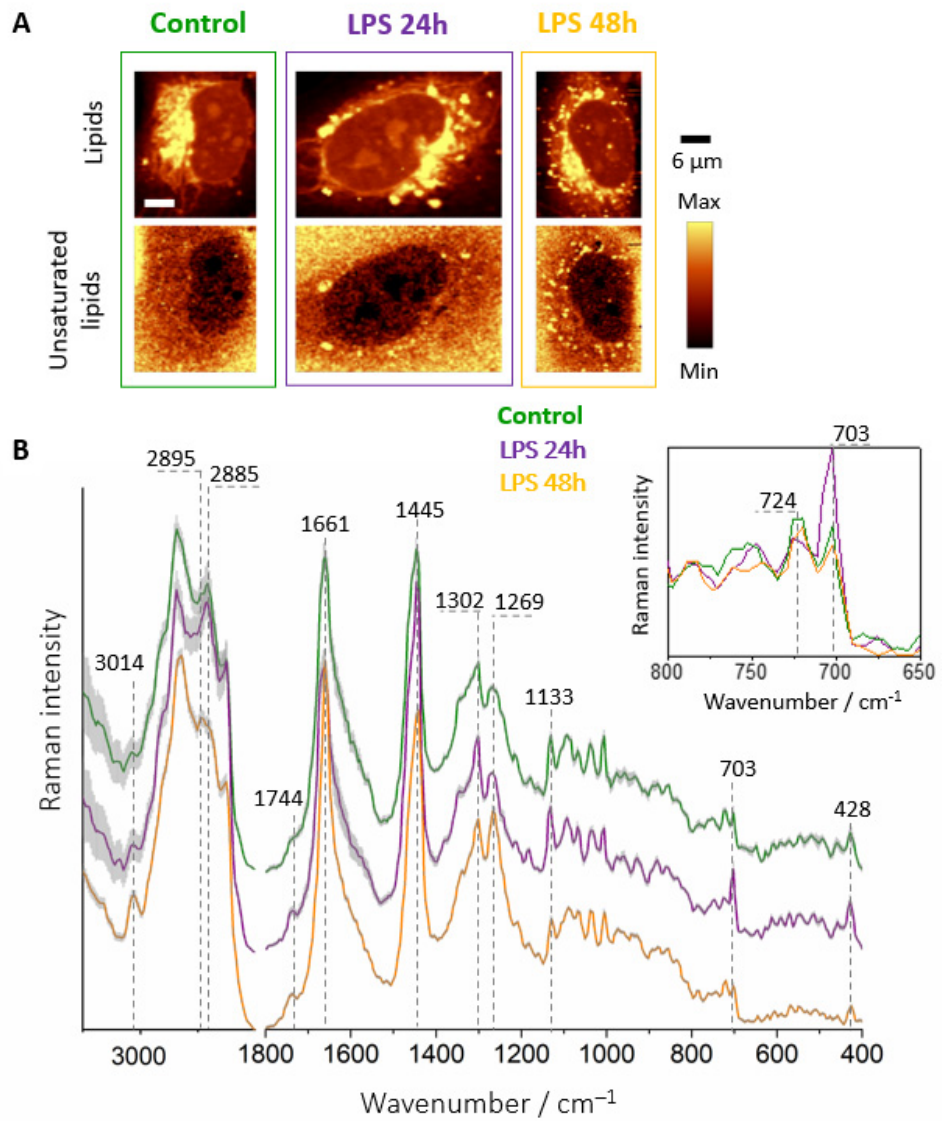
Figure 4. Raman imaging of LDs in endothelial cells. Representative Raman images of control and incubated with LPS (10 μ g·mL − 1 ) HMEC-1 for 24 and 48 h ( A ) in FBS supplemented media and Raman spectra of LDs ( B ) extracted from control and LPS-stimulated cells for 24 h (violet) and 48 h (gold) averaged over all measured cells. The insert shows changes in the intensity of the bands at 724 and 704 cm − 1 . Spectra were normalized in the 1500–400 cm − 1 spectral range and were presented with the standard error on each data point (grey area), and have been shifted vertically for clarity.